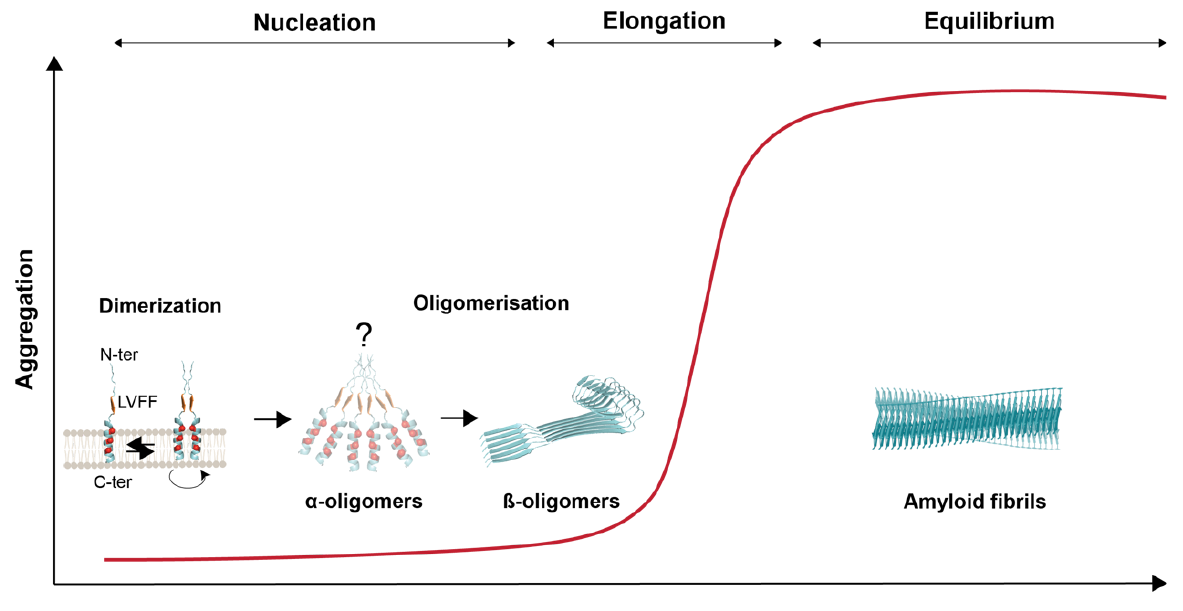
Figure 5. Steps of amyloid β aggregation. Illustration of putative nucleation steps of Aβ adapted from [152] . γ - secretase cleaves monomers of C99 (see above) but released Aβ peptides may rapidly reform dimers centered on the GxxxG motifs. In the nucleation phase, dimer formation is the initial step leading to the formation of higher-order species (hexamers are represented) whose nucleation is mediated by the Aβ C - terminus. These oligomers usually form β -sheets but may go through a transient step to form α - oligomers that rapidly switch to more stable β -oligomers initiated by the LVFF motif. Elongation occurs by assembly of β -sheet oligomers into fibrils.